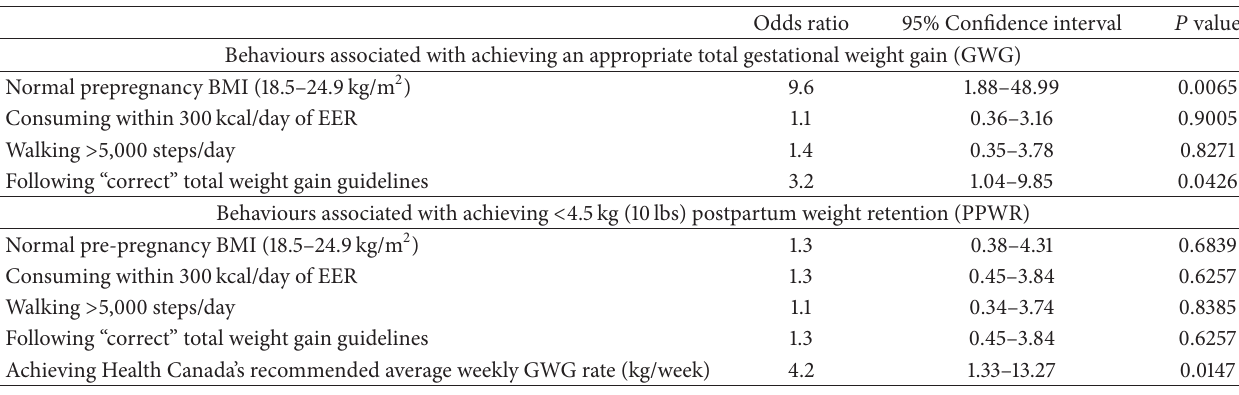
Table 2: Odds ratios identifying behaviours associated with achieving a healthy GWG and minimizing PPWR in pregnant women ( 𝑛 = 54 ) attending prenatal classes.